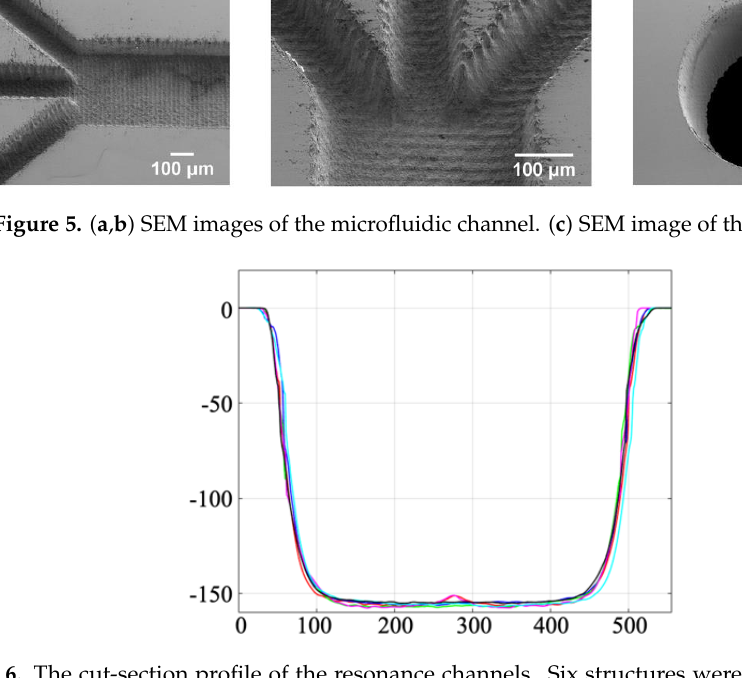
Figure 6. The cut-section profile of the resonance channels. Six structures were evaluated, and all values are in µm.